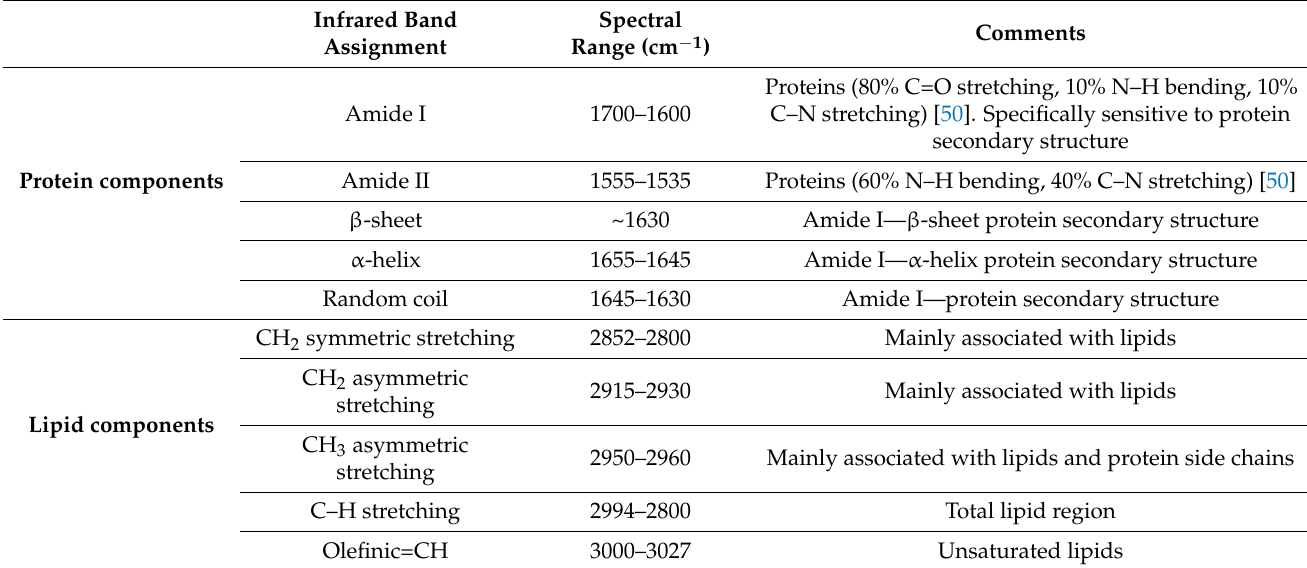
Table 1. Spectral regions used for analytical interpretation for mTBI study